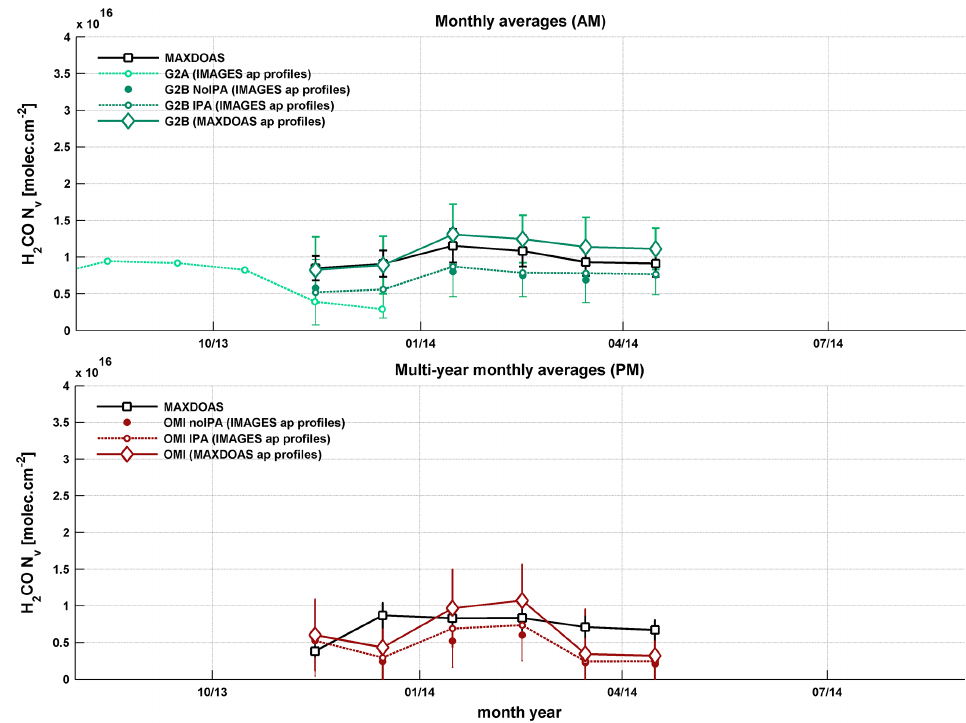
Figure 12. Validation of GOME-2 and OMI retrievals in Bujumbura, using MAX-DOAS retrievals (represented by black squares). Upper panel: mid-morning observations (GOME-2 AandB and MAX-DOAS averaged over 8–11h). Lower panel: early afternoon observations (OMI and MAX-DOAS averaged over 12–15h). Observations have been averaged per month, over the period 2013–2014, selecting correla- tive days between GOME-2/OMI and the MAX-DOAS instrument. Satellite measurements have been averaged within 100km around each location, and filtered using quality criteria as defined in Sect. 3.4. Three GOME-2B and OMI VCs are presented: IMAGES a.p. profile/no cloud correction, IMAGES a.p. profile/IPA cloud correction, and MAX-DOAS a.p. profile/IPA cloud